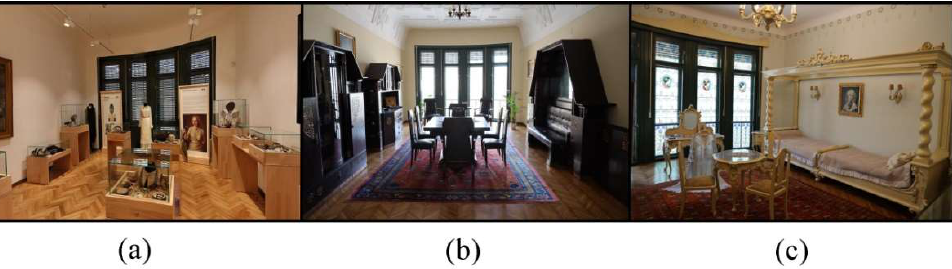
Figure 1. Location of DarvasLa Roche House at the national, county and local level.